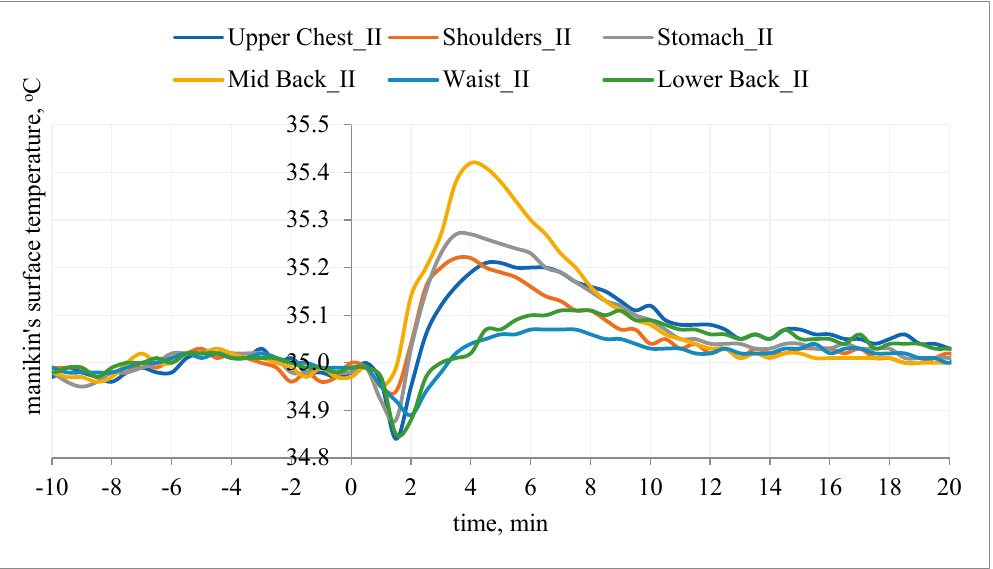
Figure 10. The manikin’s surface temperature after application of the undershirt with PCM (variant II).